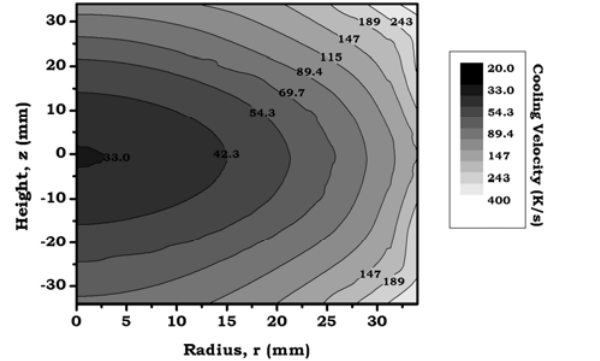
Figure 12. Cooling velocities map for the 70/70 mm foam